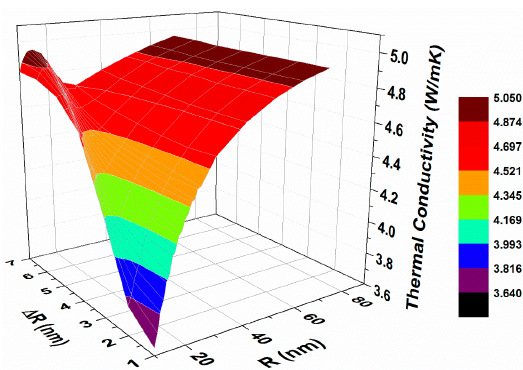
Figure 8. The lattice thermal conductivity of PbTe calculated from expression (16) as a function of the precipitate average radius and size distribution for T = 300 K and v f = 5%.